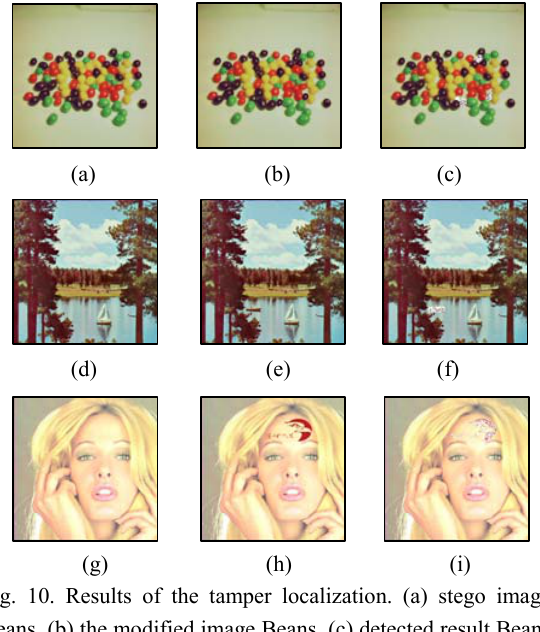
Fig. 10. Results of the tamper localization. (a) stego image Beans, (b) the modified image Beans, (c) detected result Beans, (d) stego-image Sailboat, (e) the modified image Sailboat, (f) detected result Sailboat, (g) stego-image Tiffany, (h) the modified image Tiffany, (i) detected result